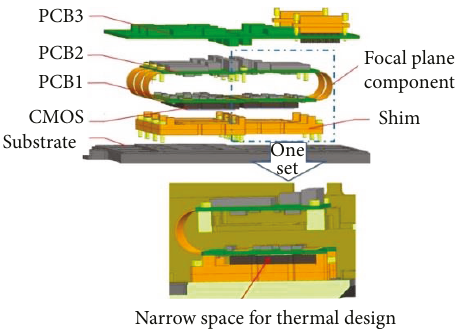
Figure 1: Internal structures of the focal plane